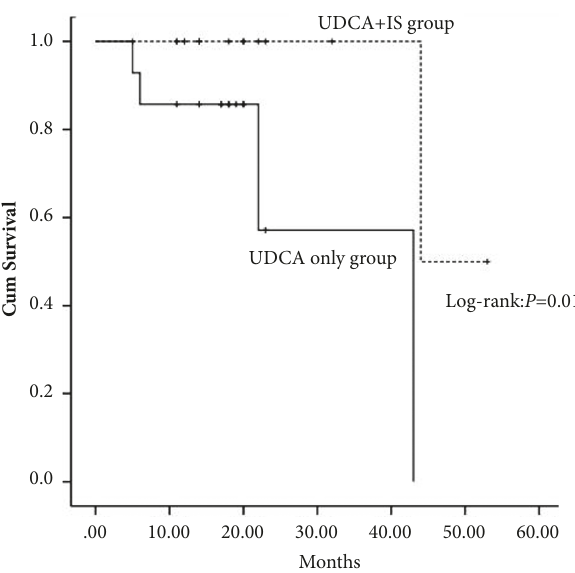
Figure 3: Transplant-free survival between the two groups (log- rank, P =